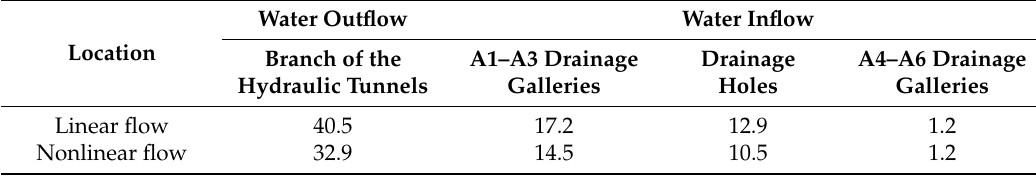
Table 5. Comparison of the flow rate for linear and nonlinear flow theories